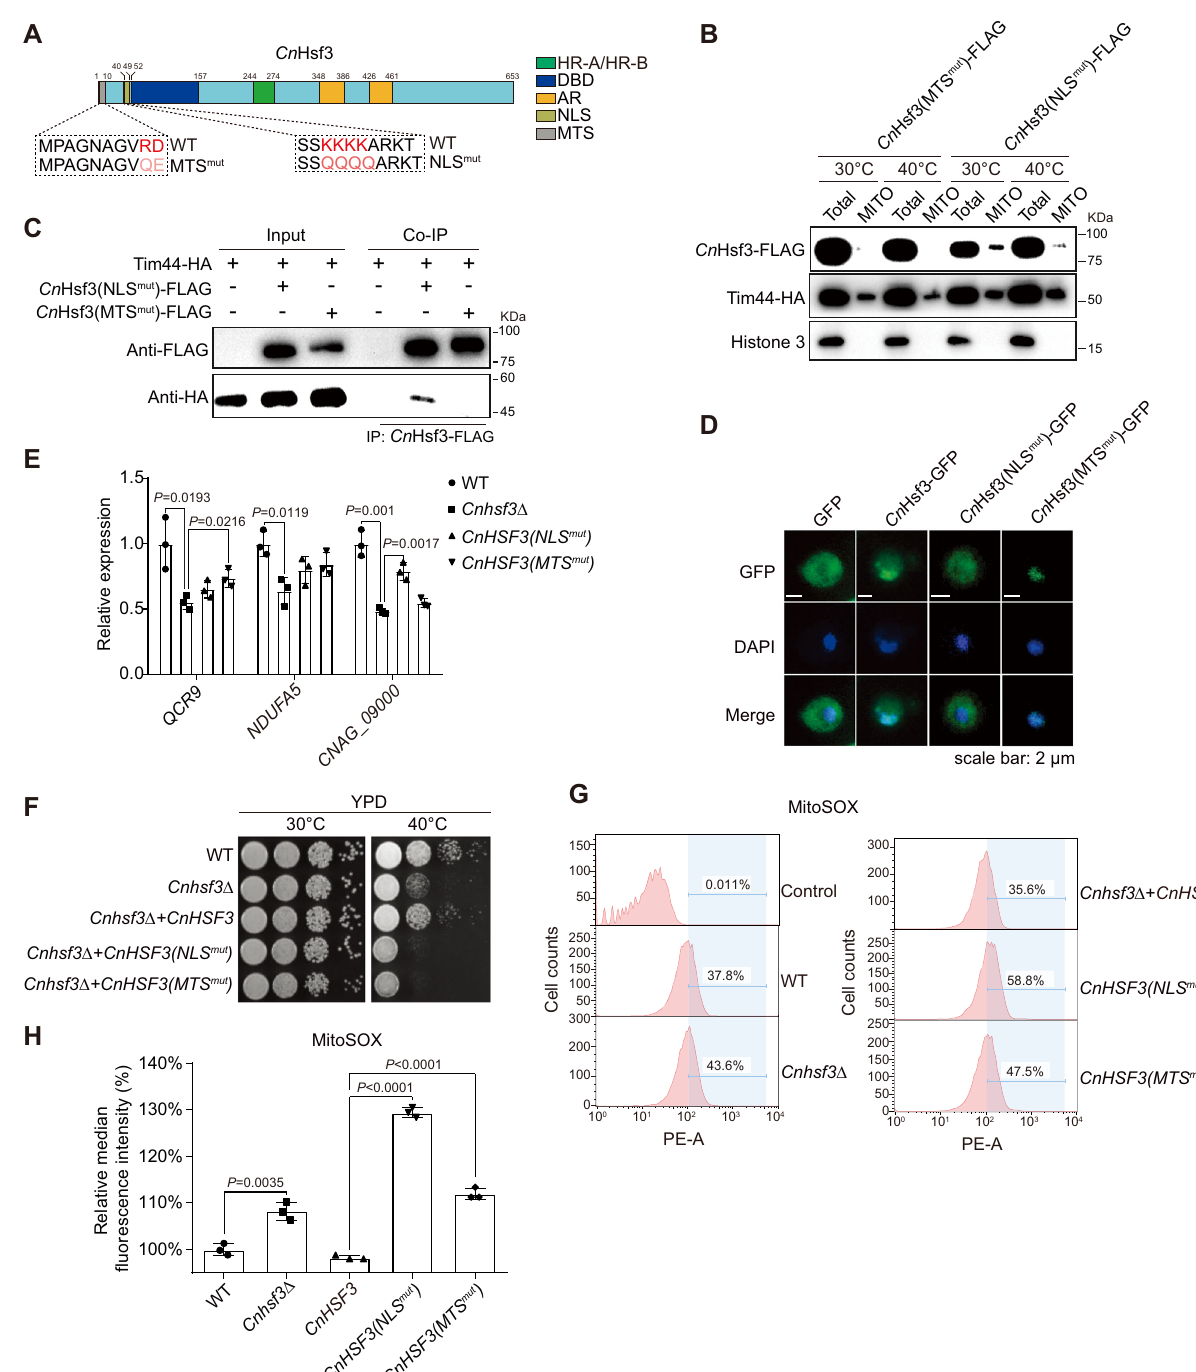
Fig. 5 | Both nuclear and mitochondrial targeting signals are required for C n Hsf3 function. A Schemes of Cn Hsf3 NLS and MTS. Lysine residues (42 – 45) of NLS were mutated to glutamine. Arginine or aspartic acid residues (9 – 10) of MTS were mutated to glutamine or glutamic acid, respectively. B Detection of Cn Hsf3 (MTS mut ) in mitochondria. Mitochondria were isolated and analyzed using immu- noblotting. Data were obtained from three independent experiments and repre- sentative images are shown. C Protein co-IP of Cn Hsf3 (MTS mut )-FLAG and Tim44- HA.Indicatedfungalstrainsweregrownat40°Cfor3h,thenco-IPwasperformed. Data were obtained from three independent experiments and representative ima- ges are shown. D Localization of Cn Hsf3 (NLS mut )-GFP. Indicated strains were incubated at 40°C for 3h, then stained with DAPI followed by microscopic